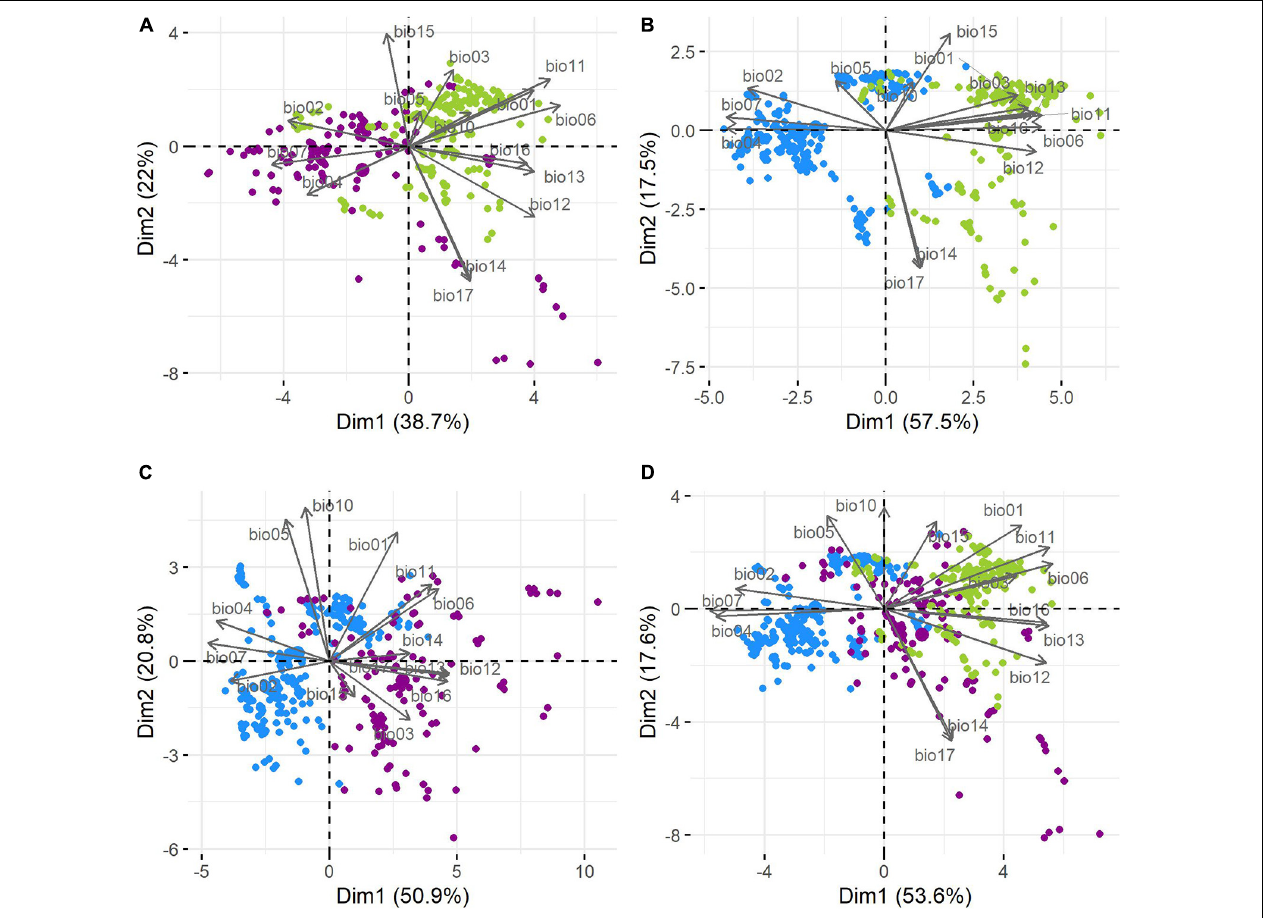
FIGURE 5 | Principal component analysis (biplots). (A) Wild and feral; (B) wild and domesticated; (C) feral and domesticated; and (D) the three cotton groups. Wild = green, feral = magenta, and domesticated = blue.